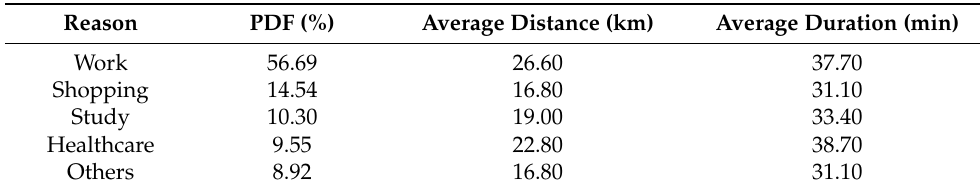
Figure 1. Trip occurrence time probabilities [23]. Table 1. Mobility pattern information